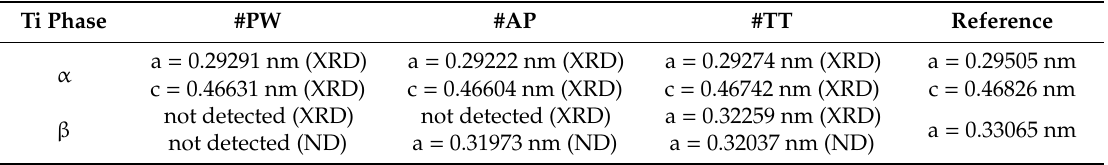
Table 2. Lattice parameters of Ti phases as estimated from XRD and ND investigations. Values from reference.